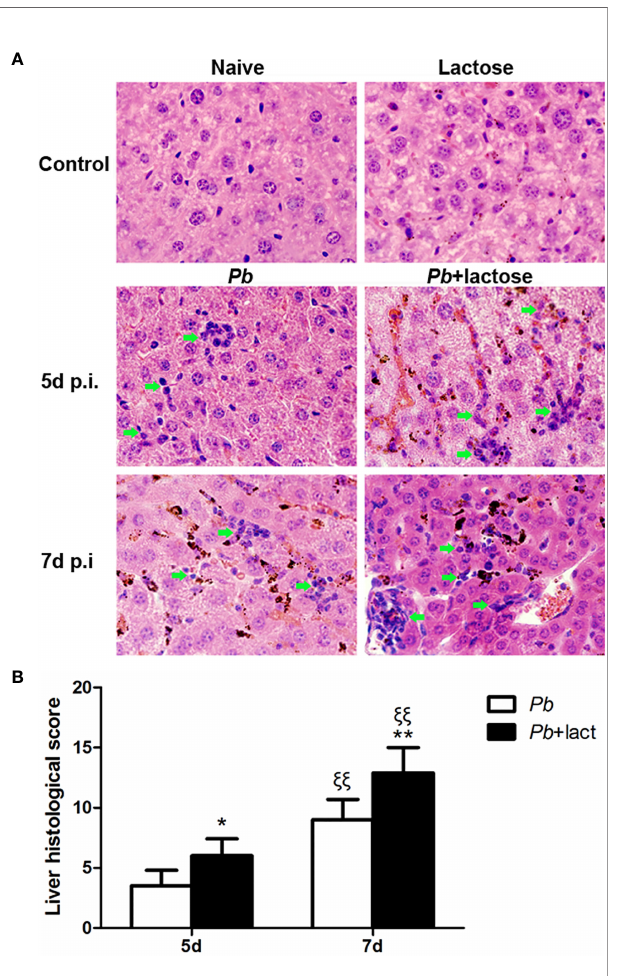
FIGURE 2 | Histopathology of livers in Pb ANKA-infected mice with or without a -lactose treatment. (A) Histopathological changes in the livers. H&E stain. In fl ammatory cell in fi ltrates were indicated with green arrow heads. (B) Histopathological score analysis of the livers. Data are represented as mean ± SD. Signi fi cant differences between groups were analyzed using Wilcoxon rank sum test. * P < 0.05 and xx P < 0.01, malarial mice with a -lactose treatment on day 5 p.i. and malarial mice on day 7 p.i. vs . malarial mice on day 5 p.i.; xx P < 0.01, malarial mice with a -lactose treatment on day 7 p.i. vs . malarial mice with a -lactose treatment on day 5 p.i.; ** P < 0.01, malarial mice with a -lactose treatment on day 7 p.i. vs . malarial mice on day 7 p.i. There were 4 mice per group, and data are representative of those from two